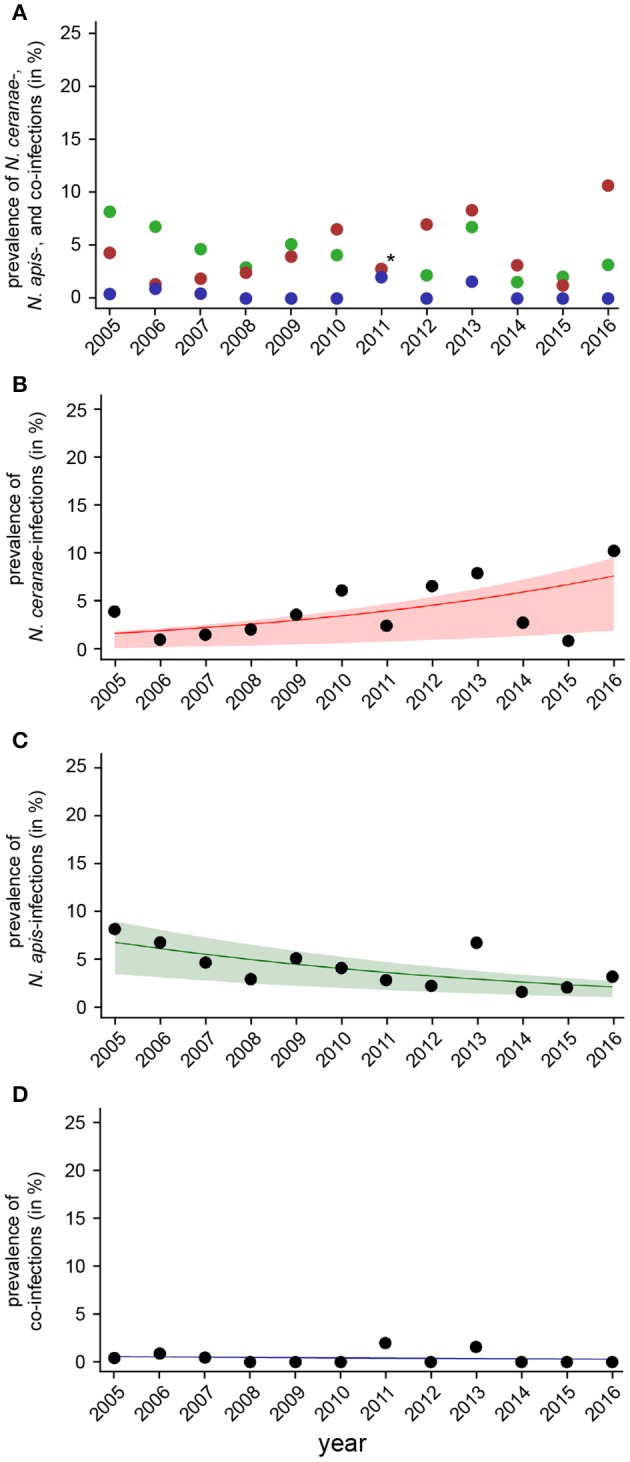
Temporal patterns of prevalence of single infections with N. ceranae or N. apis and of co-infections detected in autumn samples between 2005 and 2016. (A) Prevalence data for N. ceranae-, N. apis-, and co-infections in autumn are plotted against year. In autumn 2011, highlighted by an asterisk, the proportions of N. apis- and N. ceranae-infections were identical, hence, only a red dot is visible. (B) Data sets for prevalence of N. ceranae-, N. apis-, and co-infections in autumn were fitted by Linear Mixed-Effects Models to visualize the relationship between the independent variables (year) and the dependent variables N. ceranae- (B), N. apis- (C), and co-infections (D). Regression lines visualizing trends for N. ceranae- (B, solid red line), N. apis- (C; solid green line), and co-infection (D; solid blue line) prevalence are shown; ribbons represent the 2nd and 3rd quartile (25–75%) of the predicted data of the model.